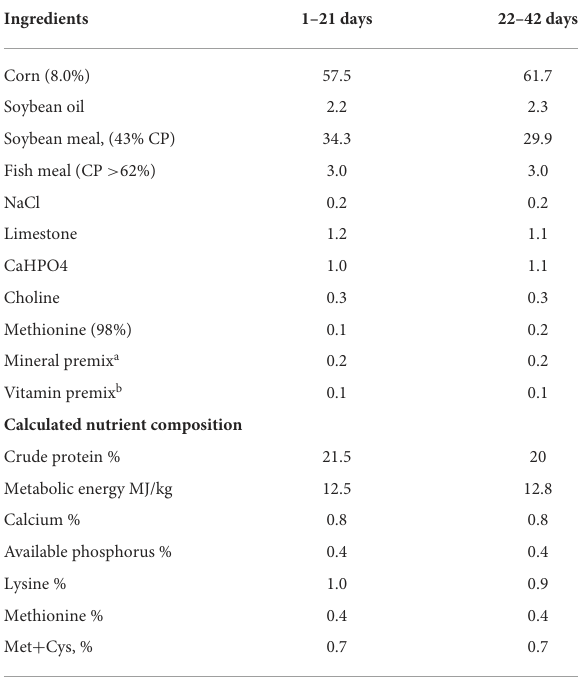
TABLE 1 The composition and nutrition level of the experimental diet (1–42